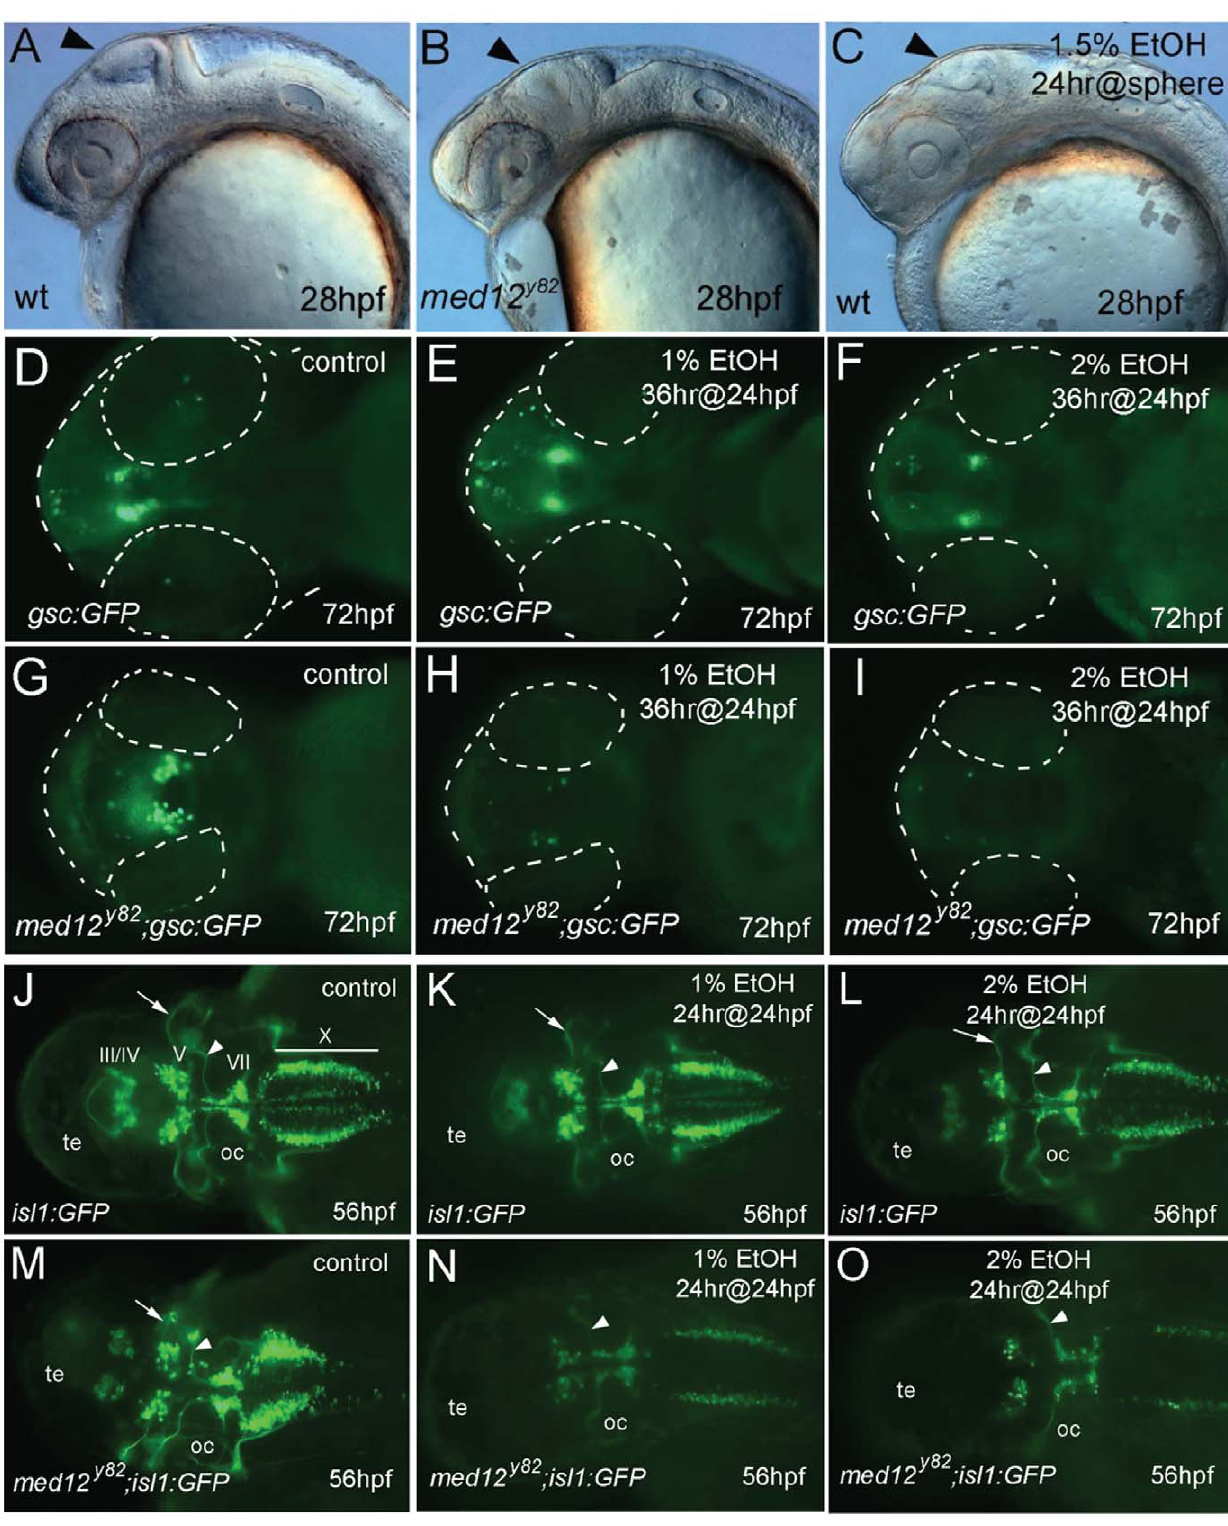
Figure 4. Neurons are sensitized to ethanol in med12 mutant embryos. A 2 C , 28 hpf embryos. A , wild-type (wt), B , med12 y82 mutant, and C , wt embryo treated at sphere stage with 1.5% ethanol for 24 hrs. Note the similarly retarded brain development in the med12 y82 and ethanol treated embryos (arrows). D 2 I , ventral views at 72 hpf of Tg(gsc:GFP) embryos (D, E, F) and med12 y82 ; Tg(gsc:GFP) embryos (G, H, I). D, G , control embryos. E, H , treated with 1% ethanol for 36 hrs at 24 hpf. F, I , treated with 2% ethanol for 36 hrs at 24 hpf. Embryos and eyes are outlined (dashed white lines). J 2 O , Tg(isl1:GFP) embryos (J, K, L) and med12 y82 ; Tg(isl1:GFP) embryos (M, N, O) at 56 hpf, dorsal views. J, M , control embryos. K, N , treated with 1% ethanol for 24 hrs at 24 hpf. L, O , treated with 2% ethanol for 24 hrs at 24 hpf. GFP-expressing cranial motor neurons (labeled) diminished in